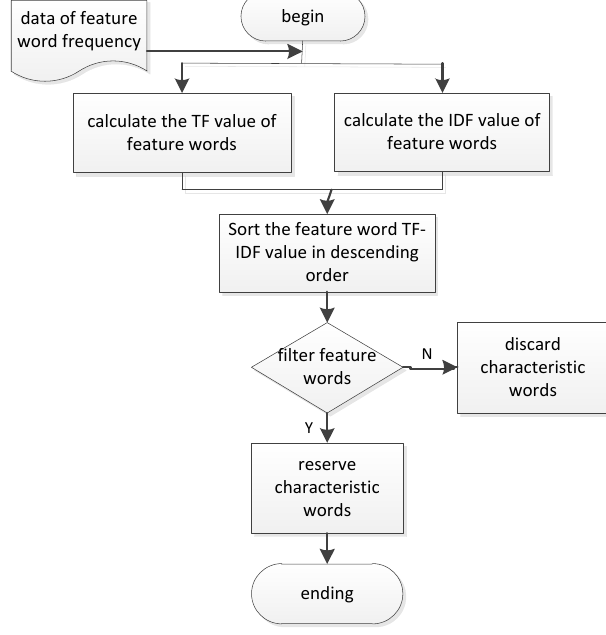
Figure 4. TF-IDF Workflow Chart.